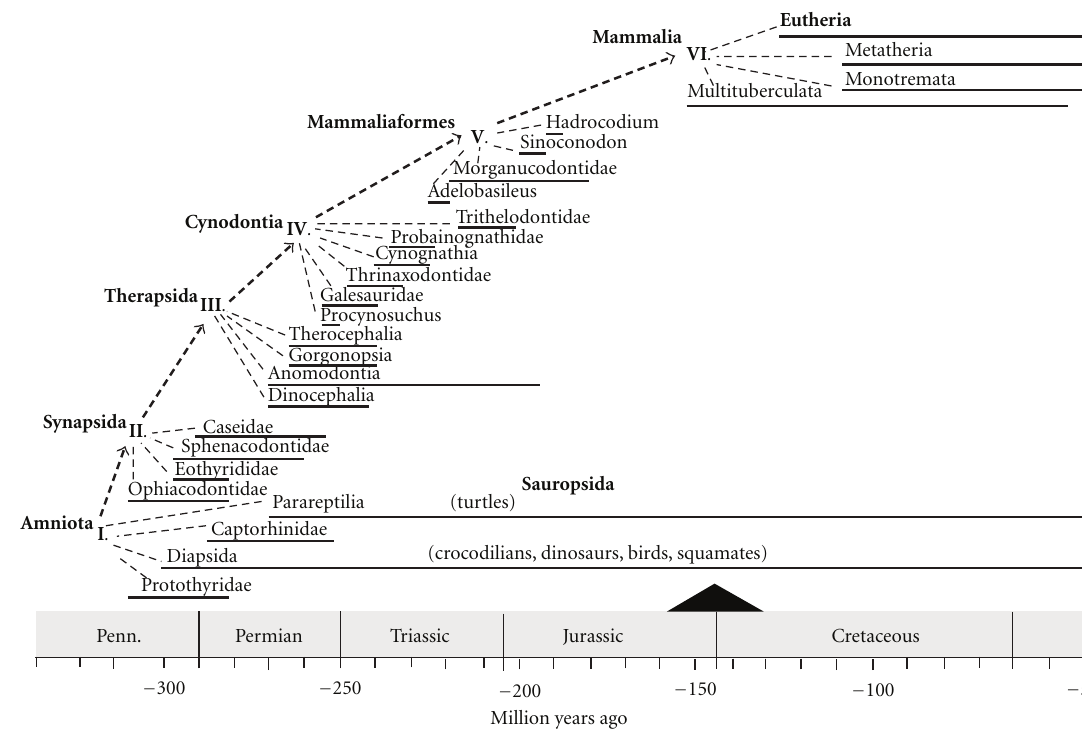
Figure 1: A simplified representation of some of the sequential, evolutionary radiations that appear from Amniota (I.) to Mammalia (II.) showing, for comparative purposes, the cladistic separation of the synapsids and saurosids as divergent subsets of Amniota. Along the dashed line, the diagram traces the trajectory from the Synapsida to the crown group, Mammalia, with select representatives of various radiating groups and species, shown by the light dashed lines. Bold horizontal lines depict the appearance and duration of each taxonomic group shown. The black triangle at the Jurassic-Cretaceous boundary denotes the end of the age of dinosaurs. The geological timescale and periods appear together at the bottom of the figure which was adapted with alterations from